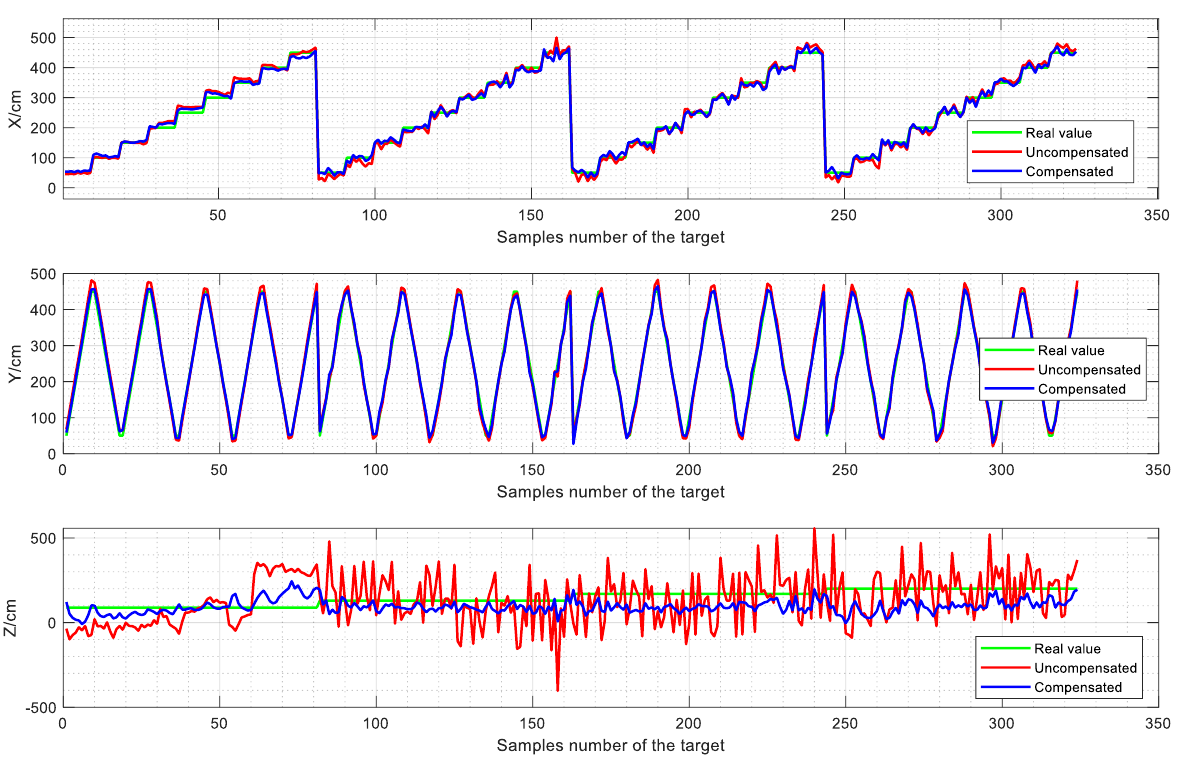
Figure 13. Comparison before and after ranging errors compensation with signal interference.